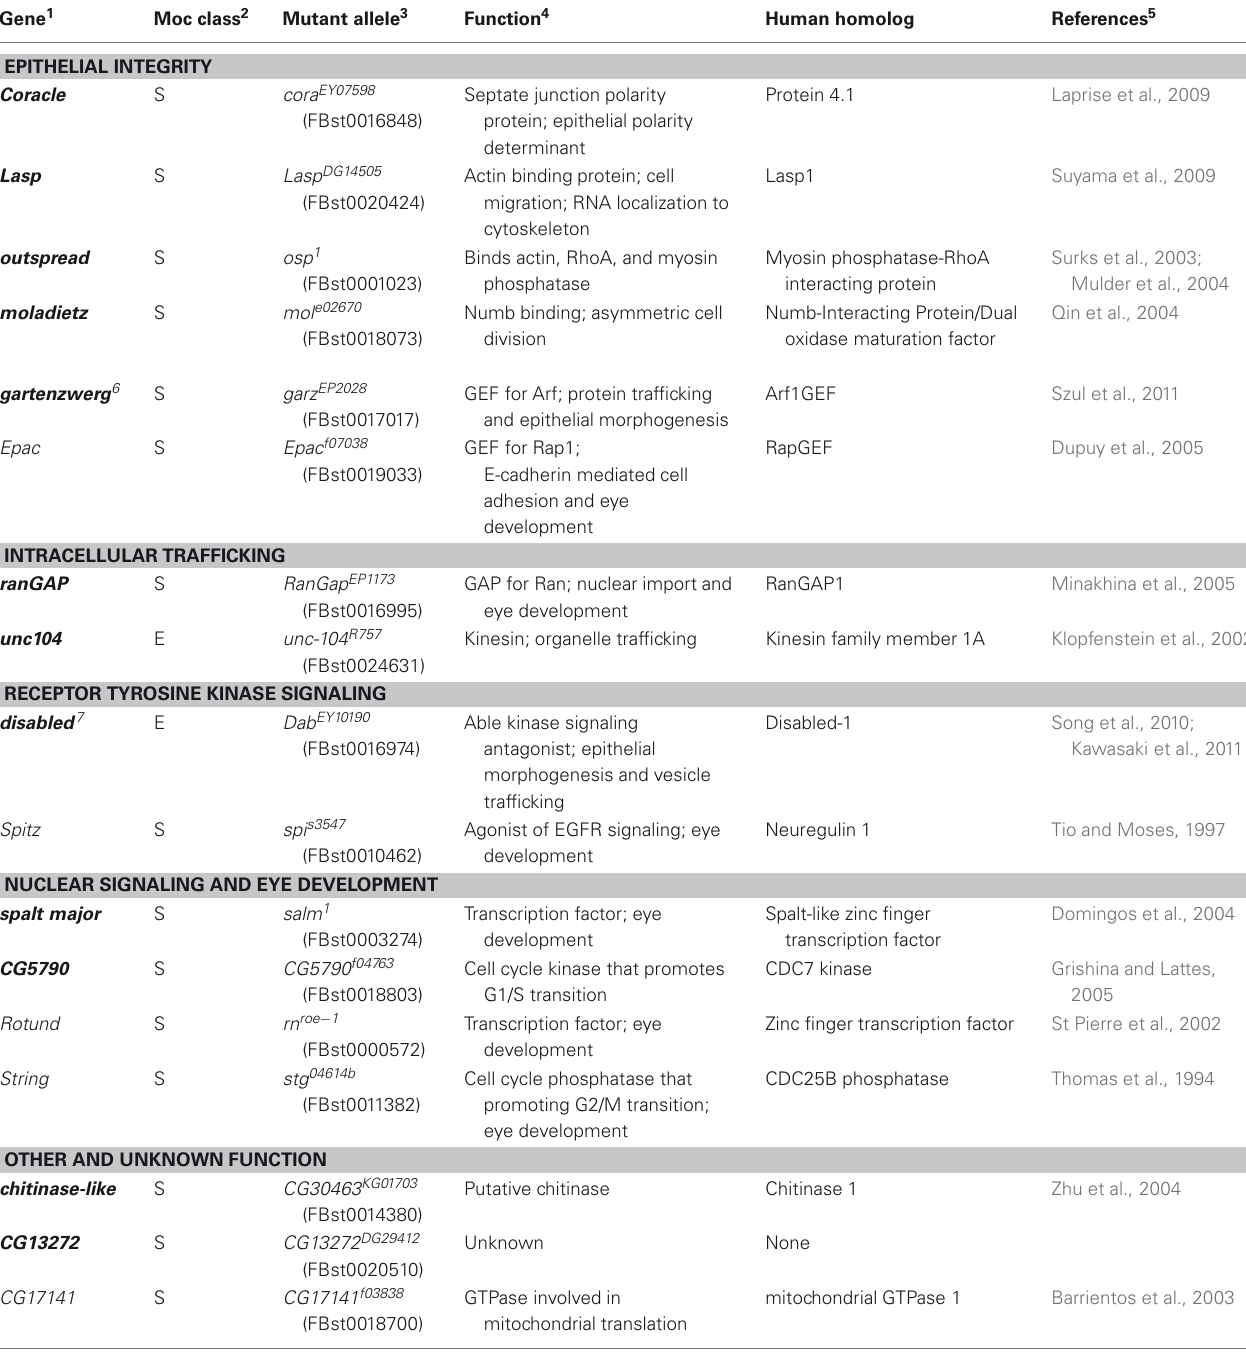
Table 1 | Moc genes identified in Drosophila adult